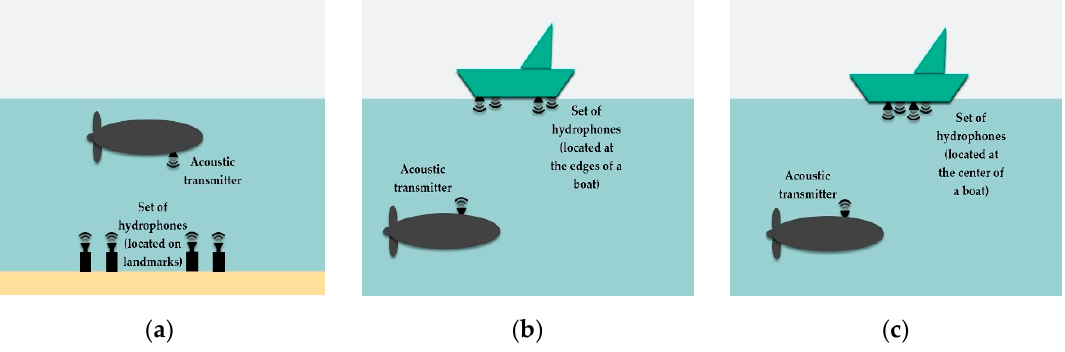
Figure 6. Acoustic localization systems: ( a ) Long Baseline, ( b ) Short Baseline, ( c ) Ultra-Short Base Line.